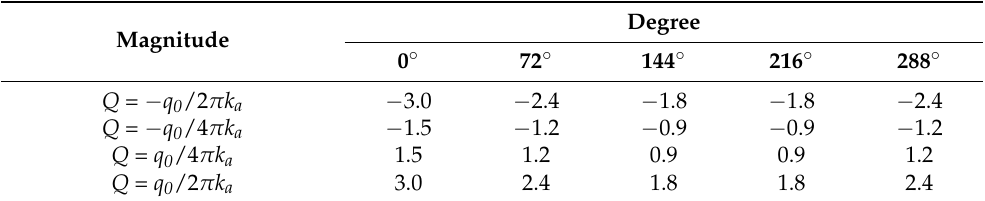
Table 1. The interfacial normal stress of each corner of the pentagonal hole under different magnitudes of heat loading.